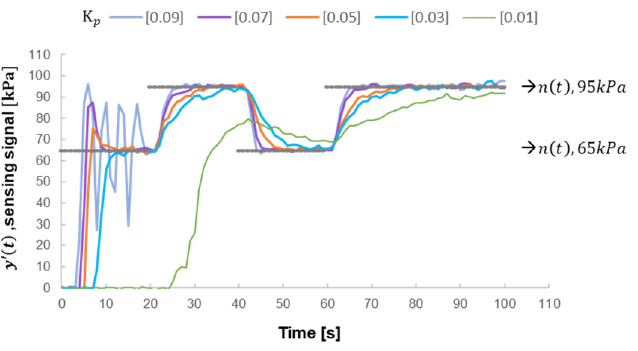
Figure 9. The grey line indicates a pulse-like curve simulating the target value n ( t ) in 65 kPa and 95 kPa, and converged at 20, 40, and 60 s. Output pressure y ’( t ) under PID parameter K p = 0.1, 0.05, 0.01, and 0.005.